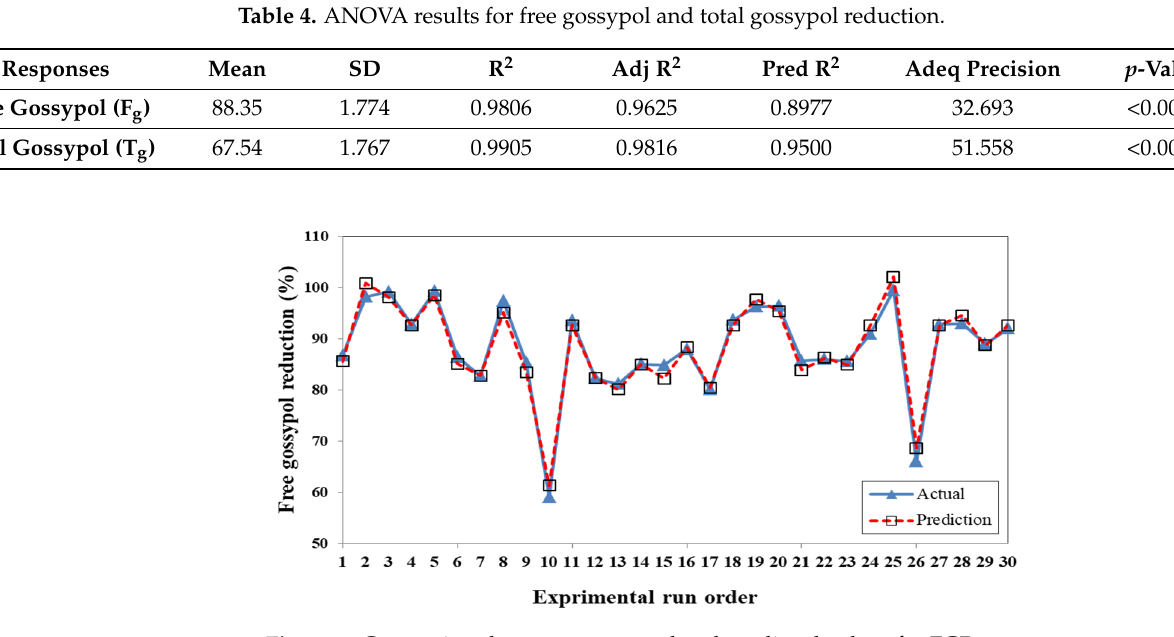
Table 3. Error analysis.